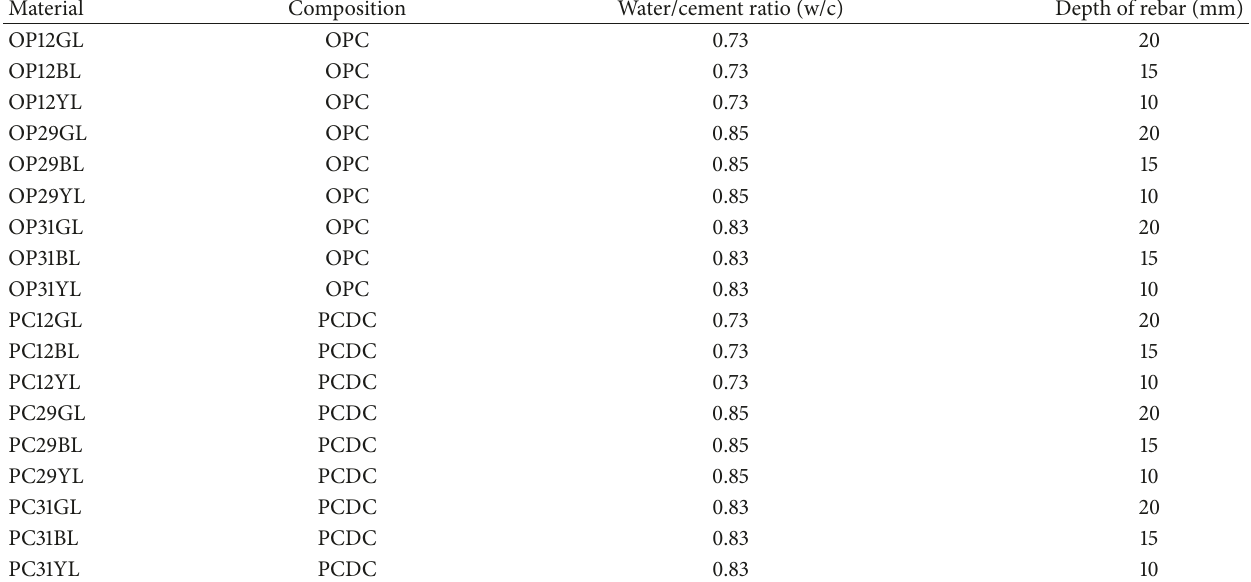
Table 3: Description of the insulated copper